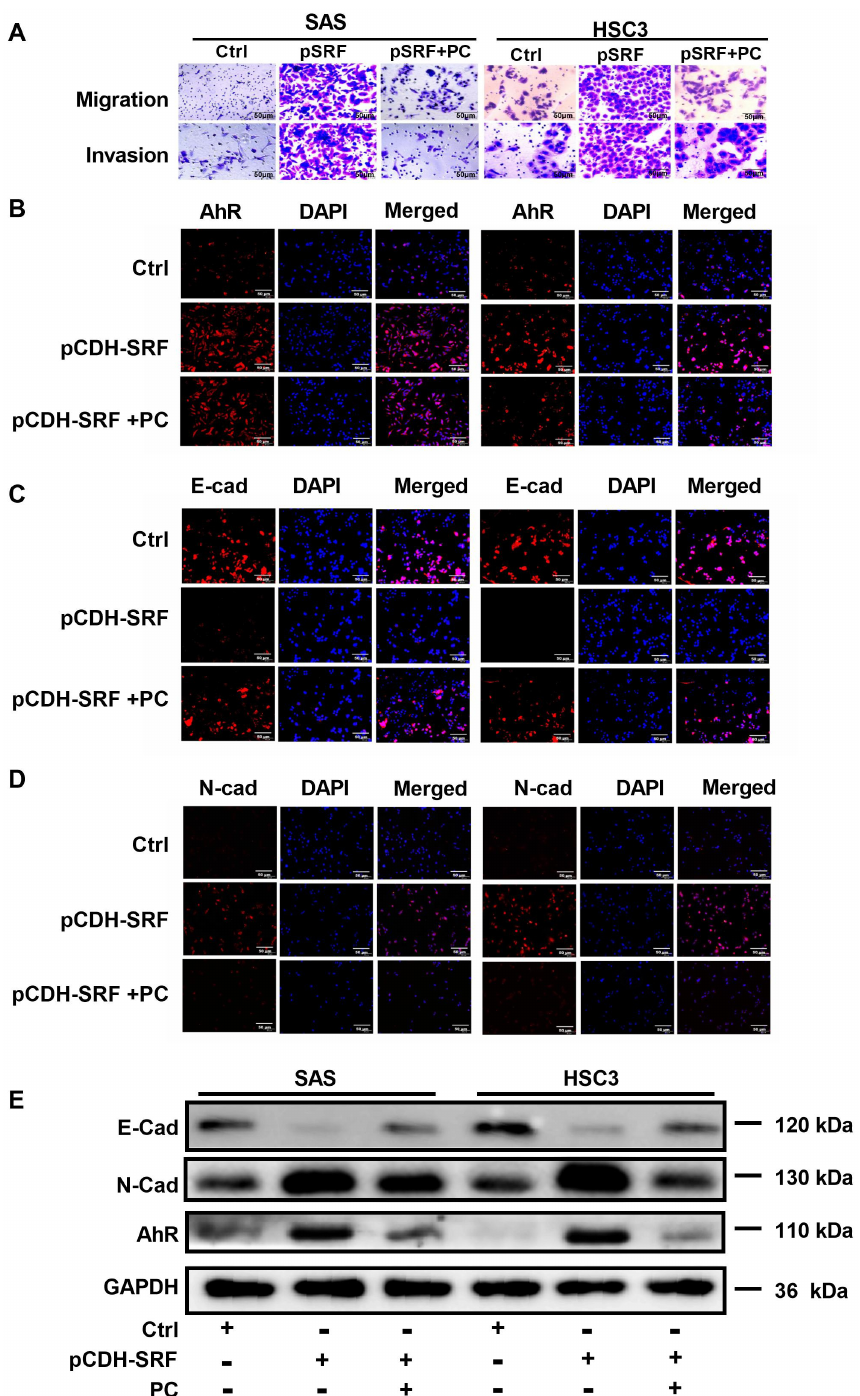
Figure 7. SRF facilitates the migration and invasion of OSCC by upregulating IDO1 transcription. ( A ) Migration and invasion assays on SAS and HSC-3 cells incubated with the IDO1 inhibitor PC. Immunofluorescence staining of AhR ( B ), E-cadherin ( C ), and N-cadherin ( D ) in SAS and HSC-3 cells after adding PC. The scale bar is shown in lower-right corner. ( E ) Western blotting results of AhR, E-cadherin, and N-cadherin in SAS and HSC-3 cells after adding PC. Original western blots are shown in Figure S8. AhR, aryl hydrocarbon receptor; E-cad, E-cadherin; IDO1, indoleamine 2,3-dioxygenase 1; N-cad, N-cadherin; OSCC, oral squamous cell carcinoma; PC, palmatine chloride; SRF, serum response